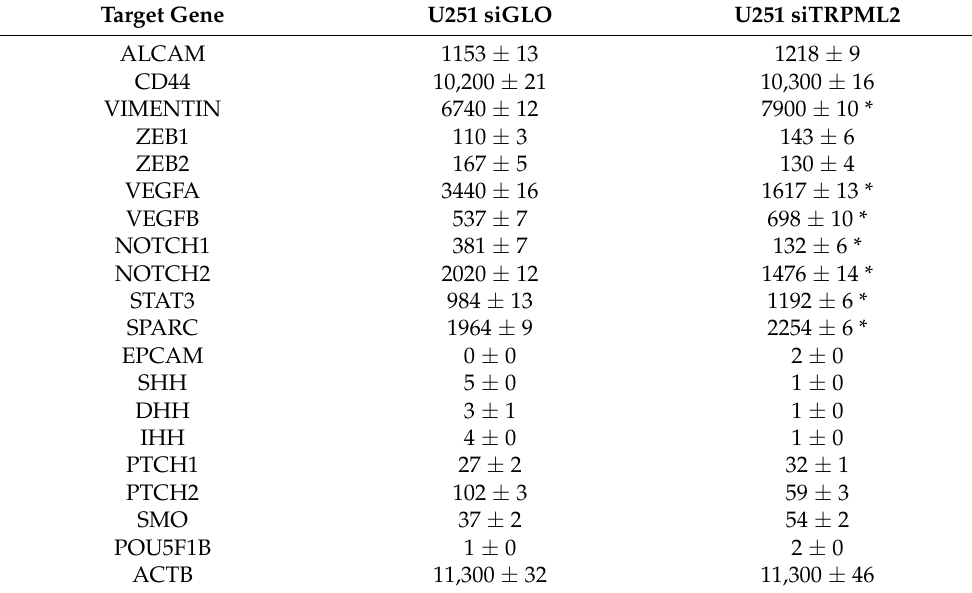
Table 2. Effects of TRPML2 silencing in the U251 cell